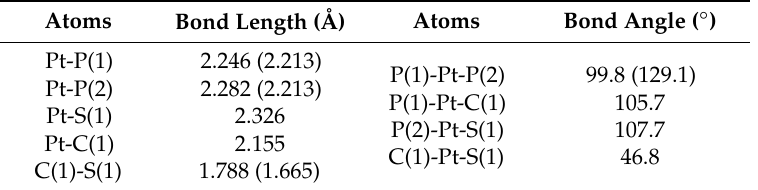
Table 1. Calculated coordination geometry around the Pt center in complex 3c . For some of the geometrical parameters, their values calculated for the isolated 1a and (dppf)Pt molecules are presented in parentheses.